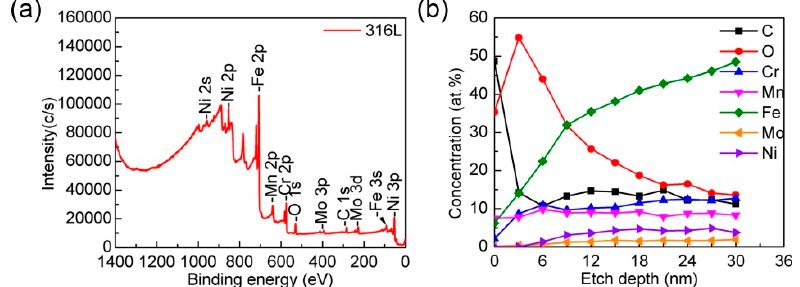
Figure 4. ( a ) X-ray photoelectron spectroscopy (XPS) survey spectrum and ( b ) depth profile analyses of element concentrations for 316L powders.